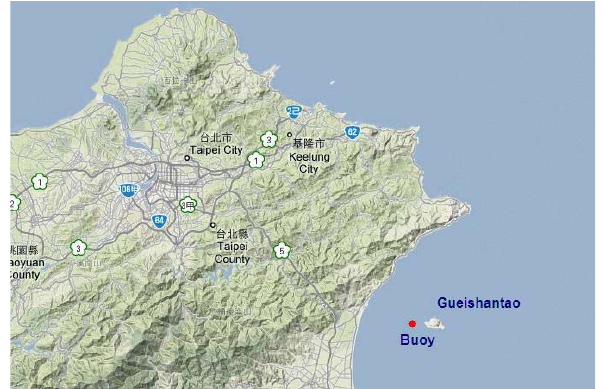
Figure 5. The buoy location near Gueishantao off the northeast coast of Taiwan.